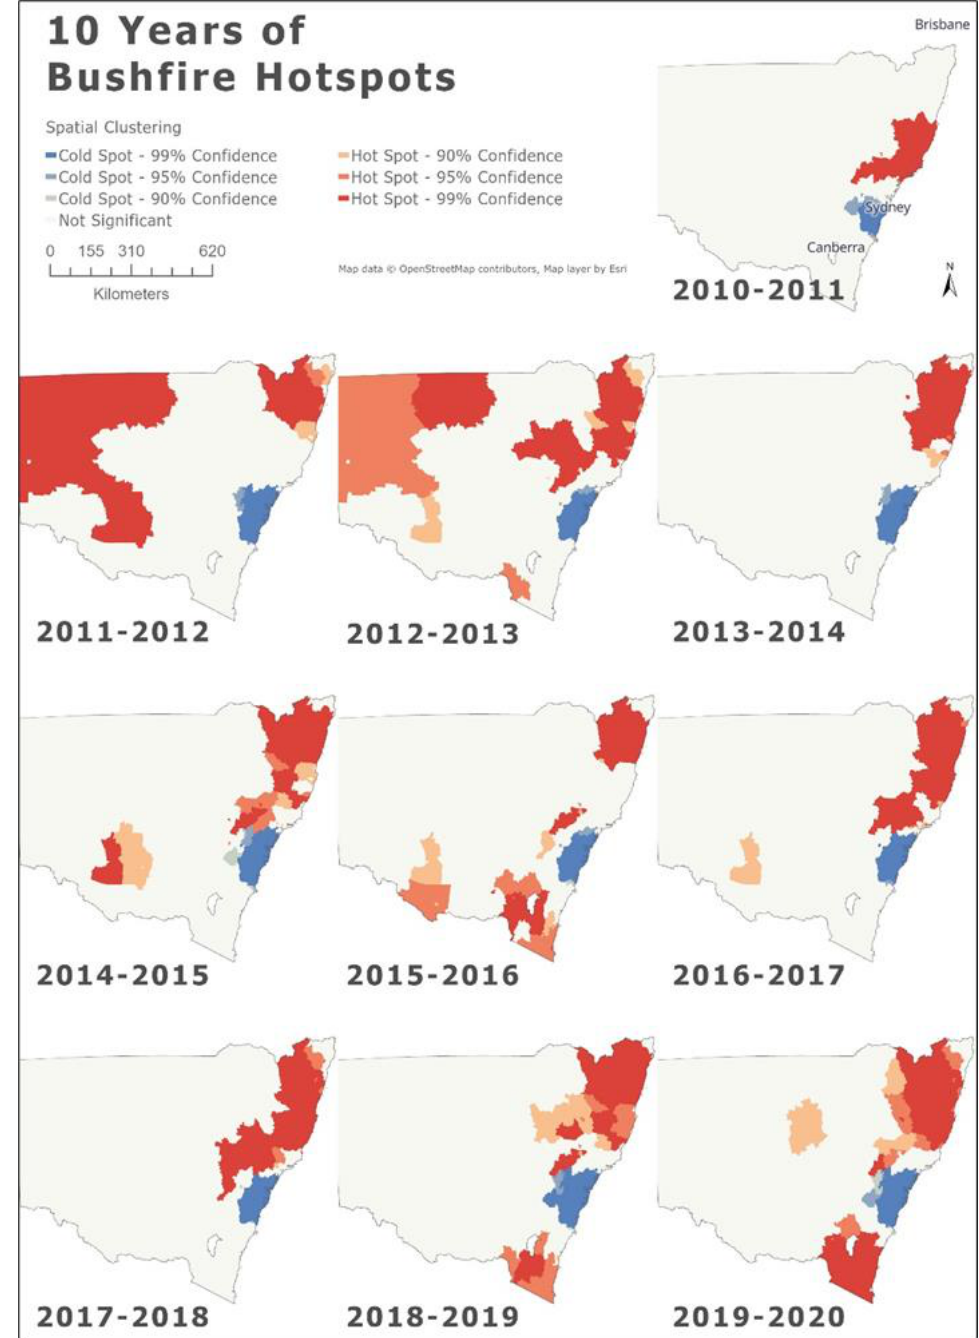
Figure 14. Bushfire frequency hotspot analysis in 2010–2020 by statistical area level 2 in NSW.